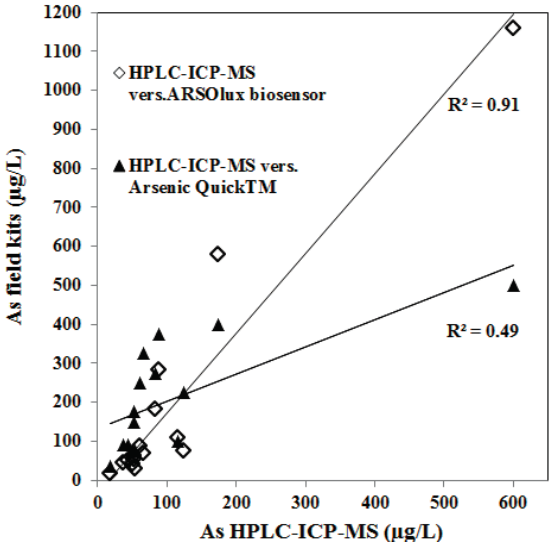
Figure 2. Cross comparison of total arsenic concentration detected by HPLC-ICP-MS and the field kits ARSOlux and Arsenic Quick ™